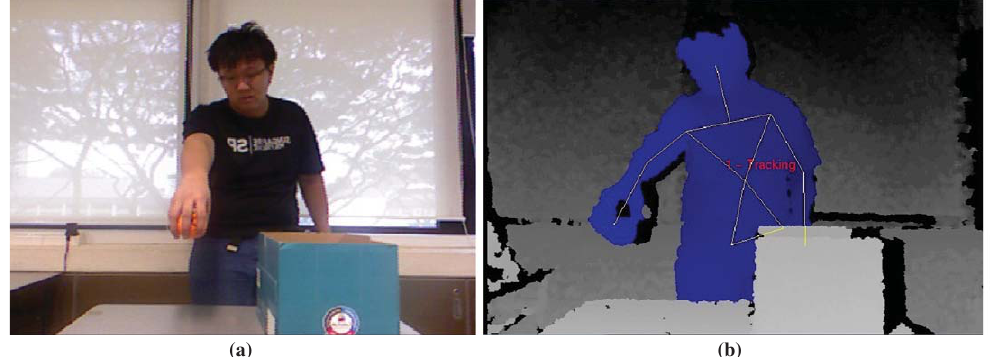
Fig. 5. Another demonstrator and its body information extracted with the OpenNI, the information of this body is merge with the colour objects to identify the actions performed with these objects, and the relation of the demonstrator body parts with the